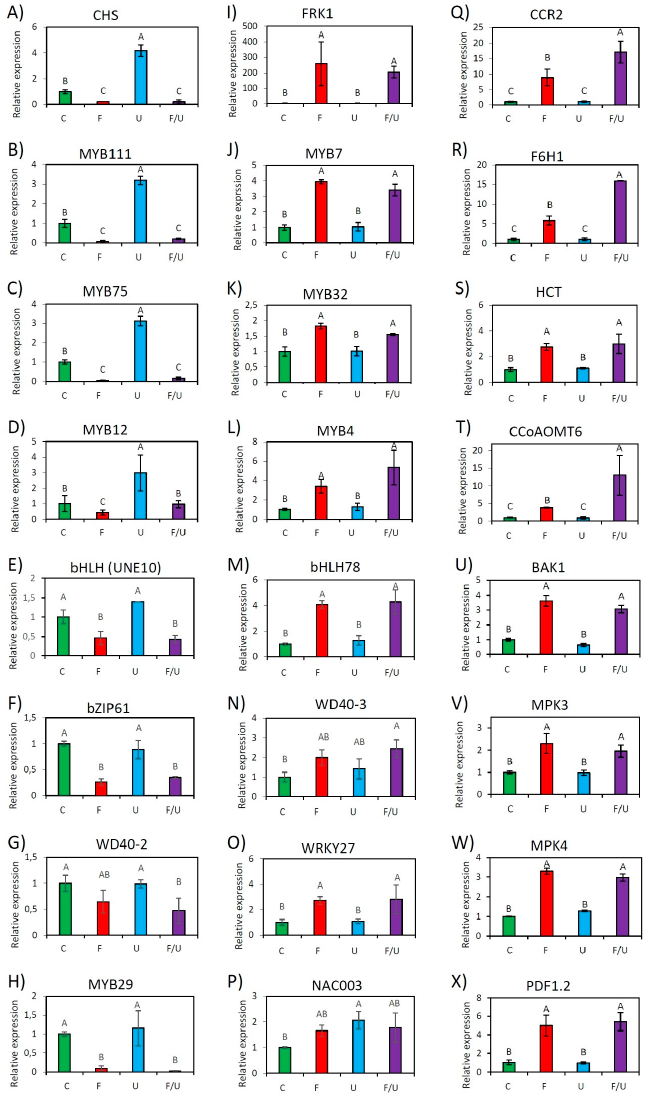
Figure 2. Relative expression levels of 24 selected genes from all identified clusters as analyzed by RT-qPCR. Shown is the response to different treatments with water as control (C), flg22 (F), UV-B